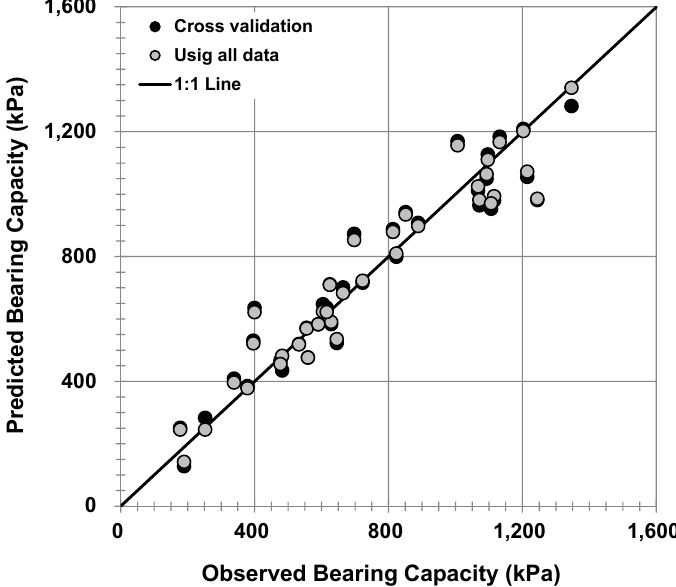
Figure 11. Comparisons of predicted and observed ultimate bearing capacity by the DNN considering the cross-validation error.